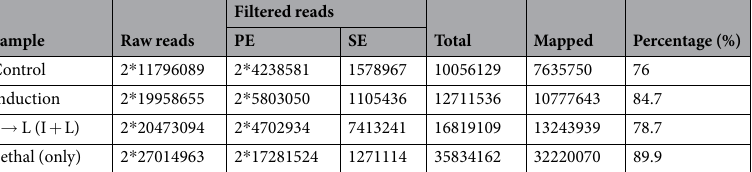
Table 1. Total number of raw reads and clean reads that were mapped from four libraries. PE: Paired end, SE: Single end.